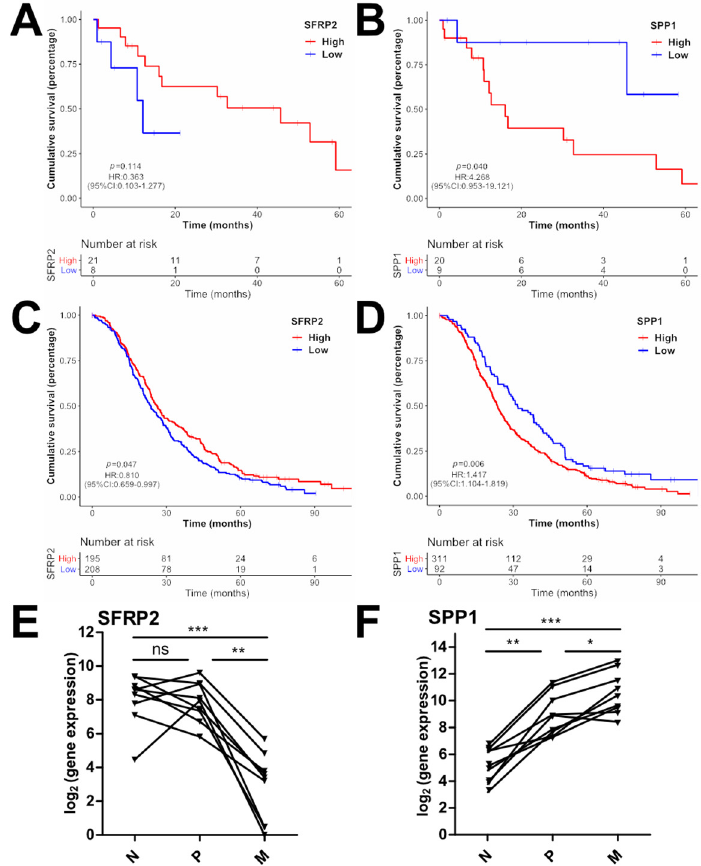
Figure 8. Prognostic role of the identified signature genes. ( A – D ) Overall survival (OS) of patients of the REVEAL ( A , B ) and FIRE-3 ( C , D ) cohorts expressing high (red curve) or low (blue curve) levels of SFRP2 ( A , C ) or SPP1 ( B , D ); p values were calculated by log-rank test. ( E , F ) Expression of SFRP2 and SPP1 in paired normal tissue (N), primary tumor (P), and metastasis (M) ( n = 9). *, p < 0.05; **, p < 0.01; ***, p < 0.001, ns, not significant.